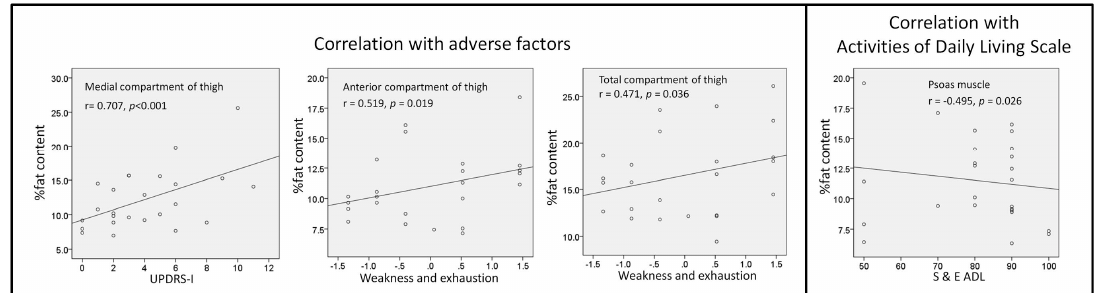
Figure 3. Among the percentage of fat content, disease severity, and frailty. The Unified Parkinson's Disease Rating Scale (UPDRS) is a comprehensive 50 question assessment of both motor and non-motor symptoms associated with Parkinson's disease. Weakness and exhaustion are parts of frailty, including lower grip strength and self-reported exhaustion, identified by two questions from the CES–D scale. Schwab and England Activities of Daily Living Scale is an assessment of an individual’s ability to function in activities of daily living. Rated in 10% increments: 1) 100% = completely independent, 2) 0% = vegetative.